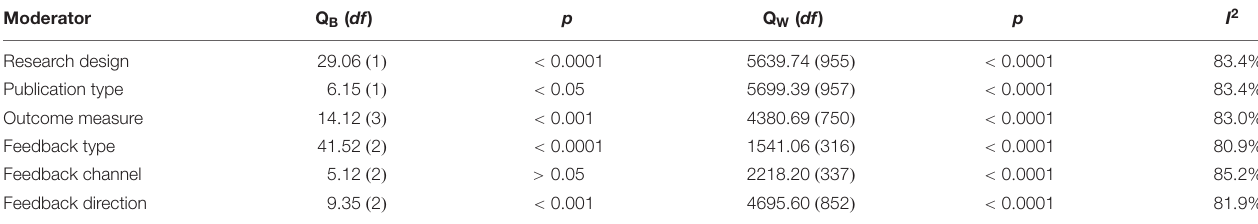
TABLE 2 | Tests of heterogeneity between and within the moderator subgroups.